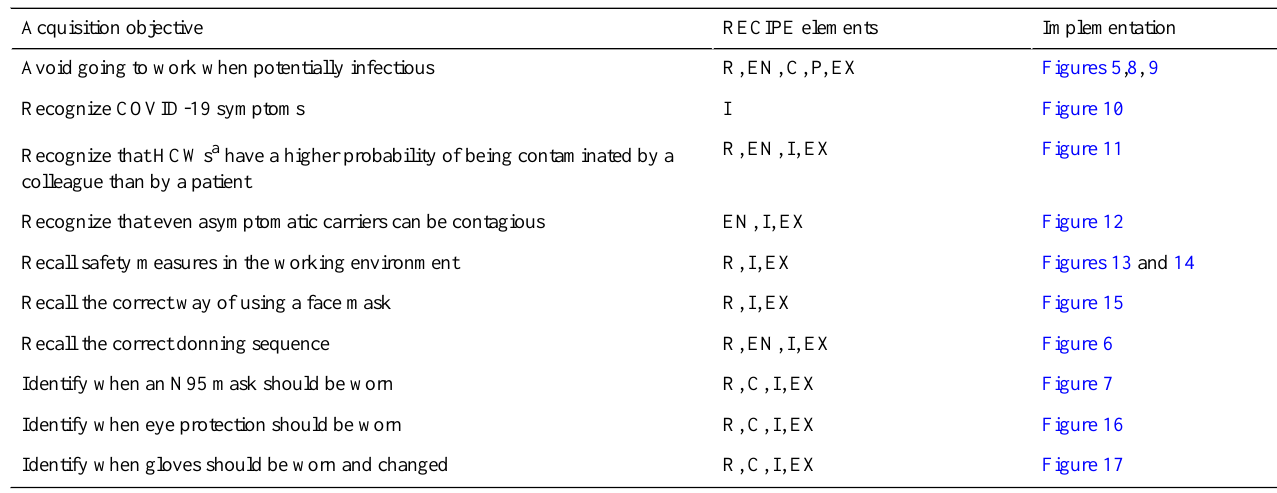
Table 1. Acquisition objectives, RECIPE (R=reflection, EN=engagement, C=choice, I=information, P=play, and EX=exposition) elements, and implementation examples.